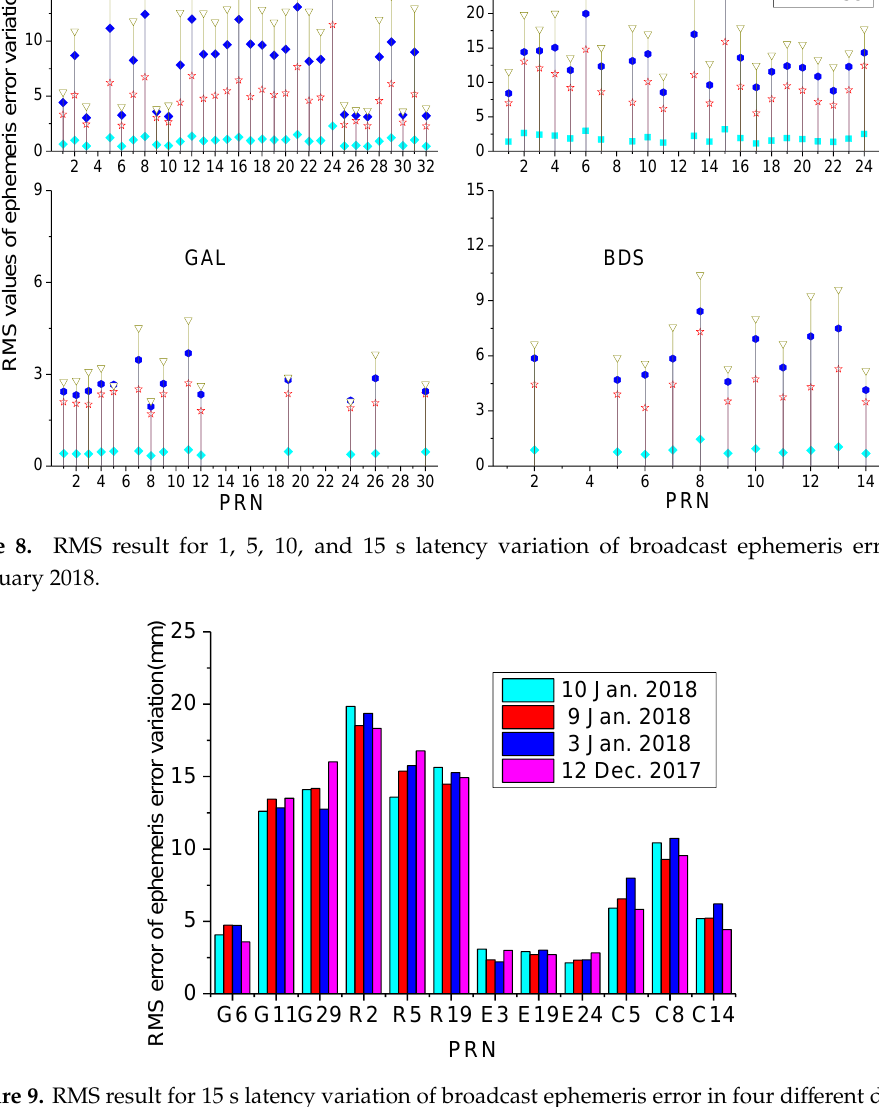
Figure 9. RMS result for 15 s latency variation of broadcast ephemeris error in four different days .